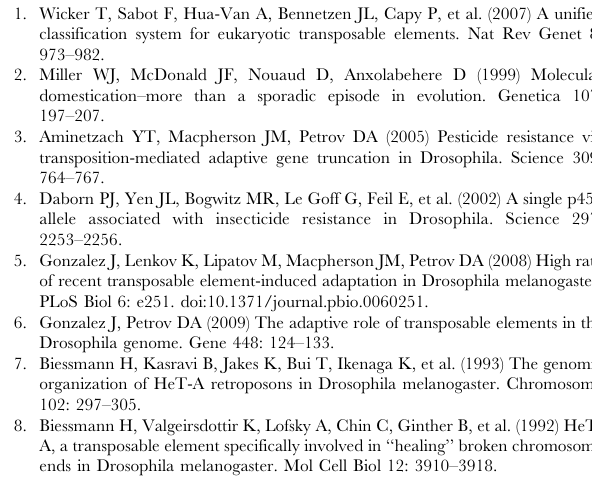
Figure S2 Nucleotide diversity in the vicinity of the 13 candidates of positively selected TE insertions. Nucleotide diversity was calculated for non-overlapping windows of size 2.5 kbp in a region of 100 kbp.